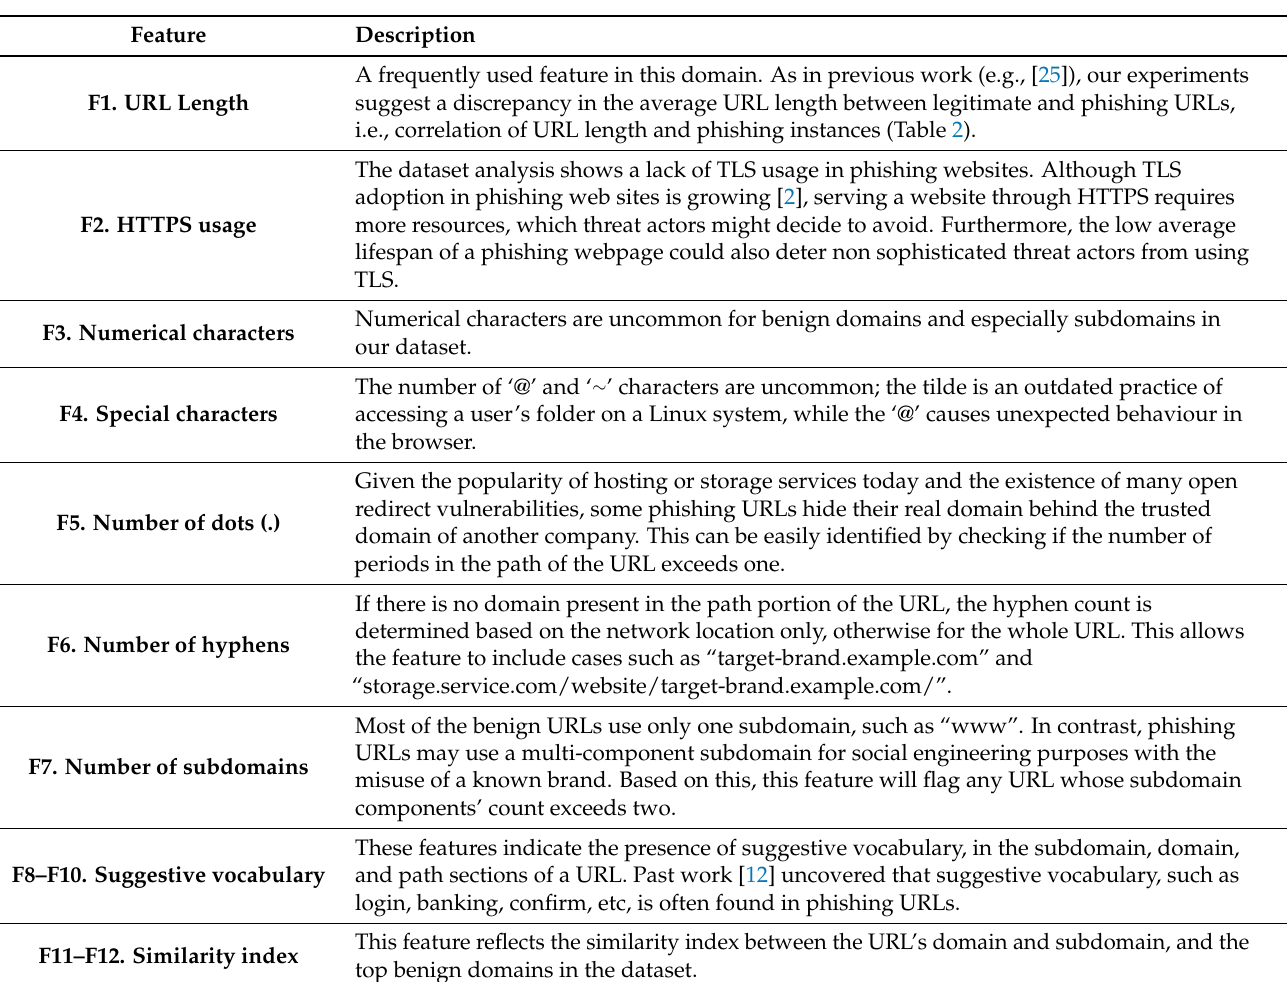
Table 1. Summary of features used.